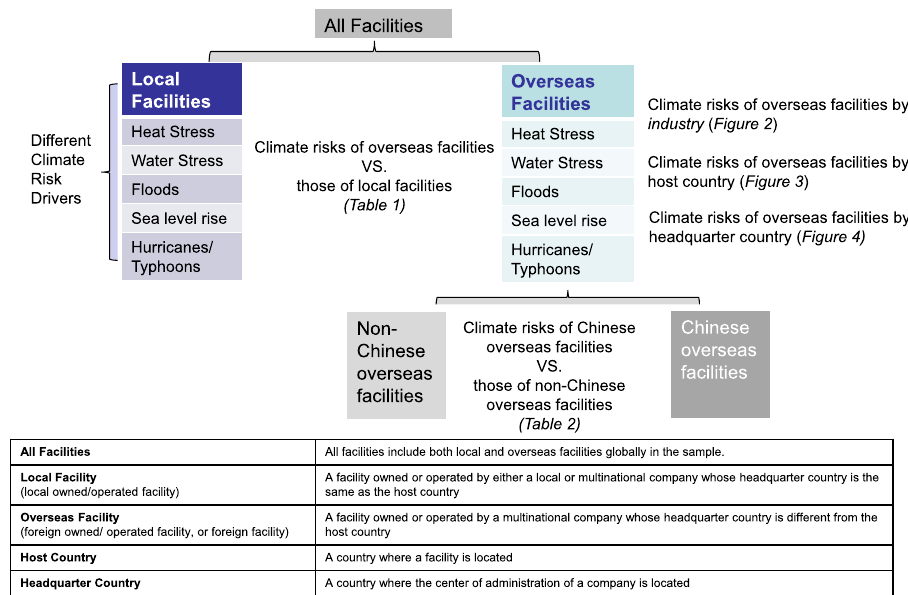
Fig. 1 Paper structure and terminology. Presents the structure of the study and explains key terminologies used in the